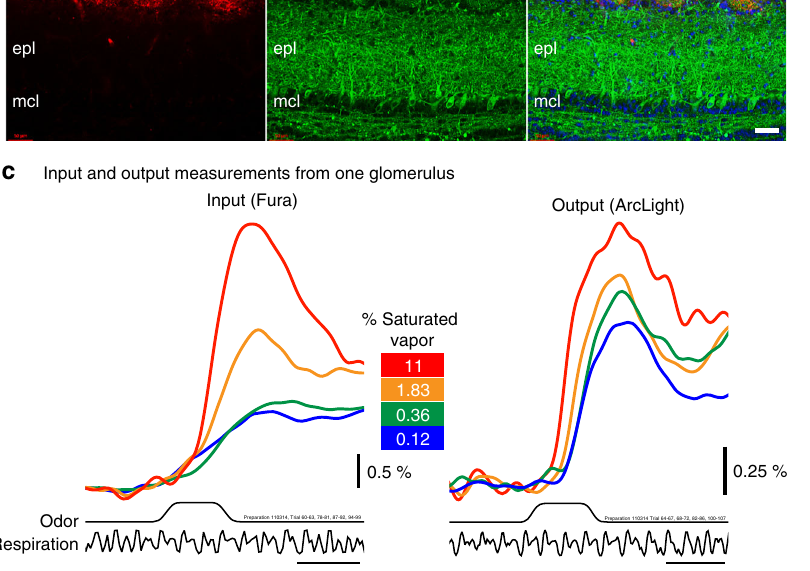
input to decrease by 88 ± 1%, whereas the output decreased by only 51 ± 4% (Fig. 2d, p < 0.001). Similar p values were observed for the comparisons at 0.36 and 1.83% of saturated vapor (0.36%: p < 0.001; 1.83%: p < 0.001; detailed statistics are included in Supplementary Table 2). Fig. 2; 0.36%: p = < 0.001; 0.12%: p < 0.001), Cal-590 and